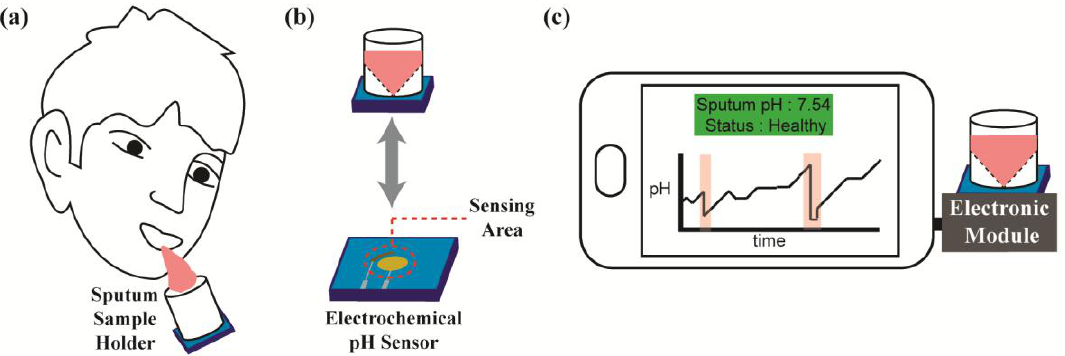
Figure 1. Overview of the smartphone-based pH sensor platform with ( a ) sputum collection via a sample holder, the bottom of which is ( b ) a reusable electrochemical pH sensor. ( c ) The entire holder attaches to an external electronic module that plugs directly into the headphone port of the smartphone to make and track measurements via a custom app.